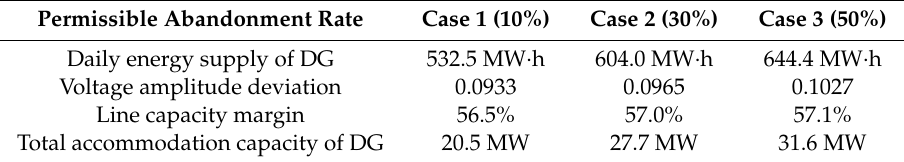
Table 5. Sensitivity analysis results considering di ff erent abandonment